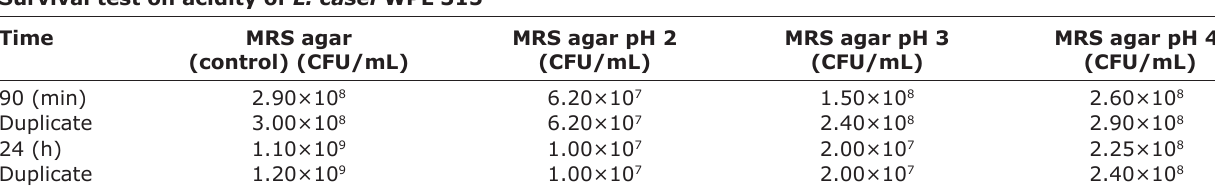
Table-3: LAB survival test on acidity Survival test on acidity of L. casei WPL 315